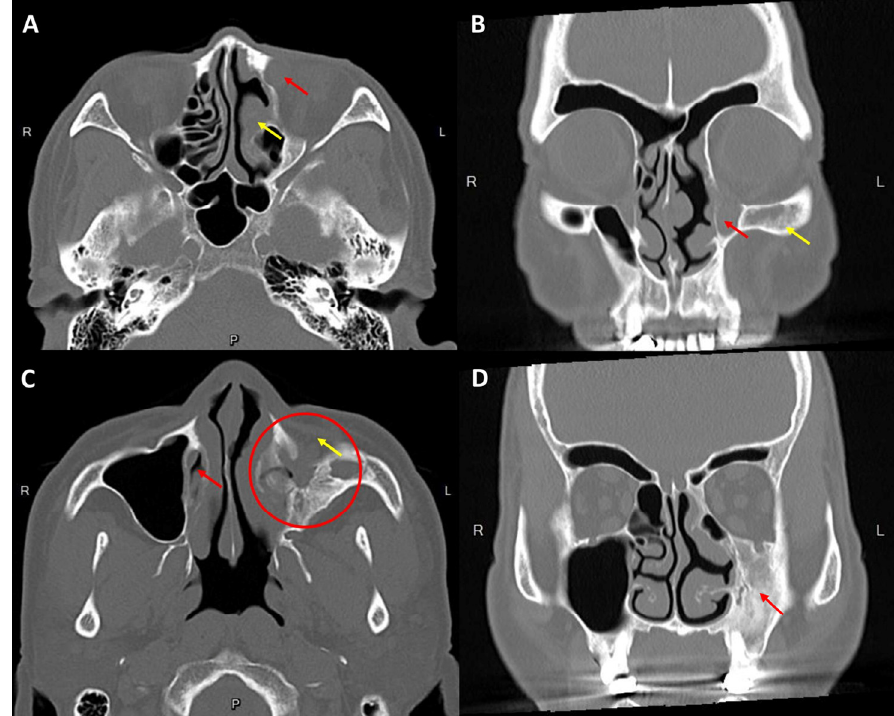
Figure 1. ( A ) Axial section through the lacrimal sac shows an expanded lacrimal sac (red arrow) and ethmoidectomy with superior turbinate hypertrophy on the left (yellow arrow). ( B ) Coronal computed tomography (CT) scan shows a prominent dilated intraosseous part of the left nasolacrimal fluid-filled duct (red arrow) and osseous proliferation of the left maxillary sinus (yellow arrow). ( C ) The lower axial section shows the intact terminus of the nasolacrimal canal on the right, within the inferior nasal meatus (red arrow), and totally obliterated on the left due to osseous proliferation and shrinkage of the left maxillary sinus (red circle). A bony defect of the anterior sinus wall (yellow arrow) was also observed. ( D ) The coronal CT scan shows osseous thickening, sinus retraction, and cavity volume reduction on the left maxillary sinus (red arrow) and increased volume of the left orbit.